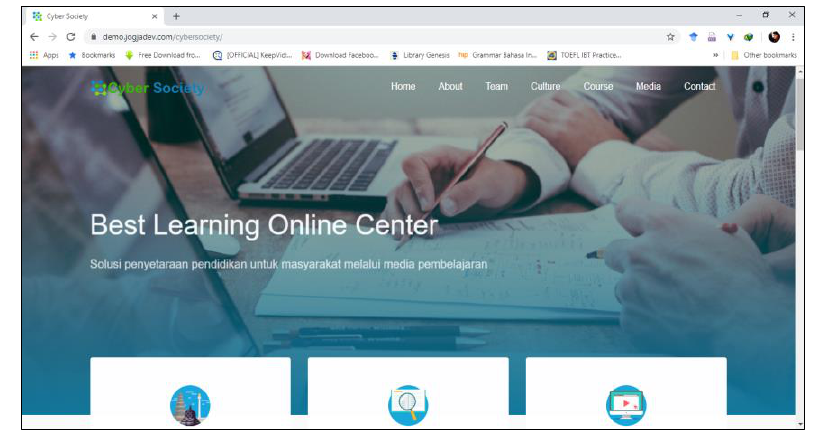
Fig. 5. Front page of the